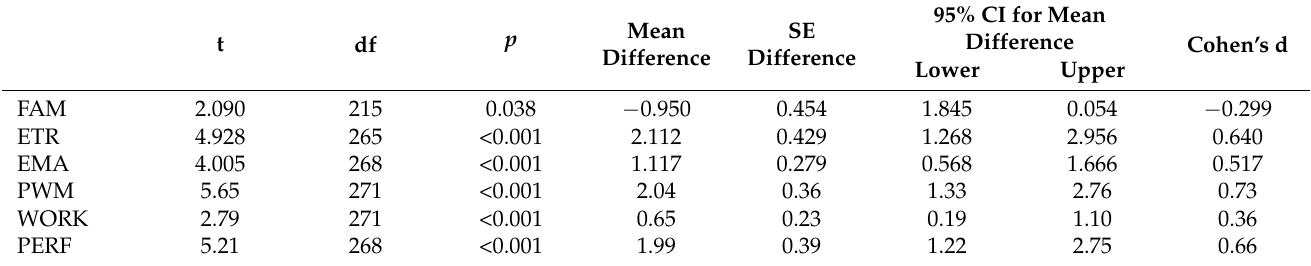
Table 5. Independent Samples T-Test on the differences between nationality on the relevant constructs checked with gender as a grouping variable. For the Student t -test, the effect size is given by Cohen’s d. For the Student t -test, the location parameter is given by the mean